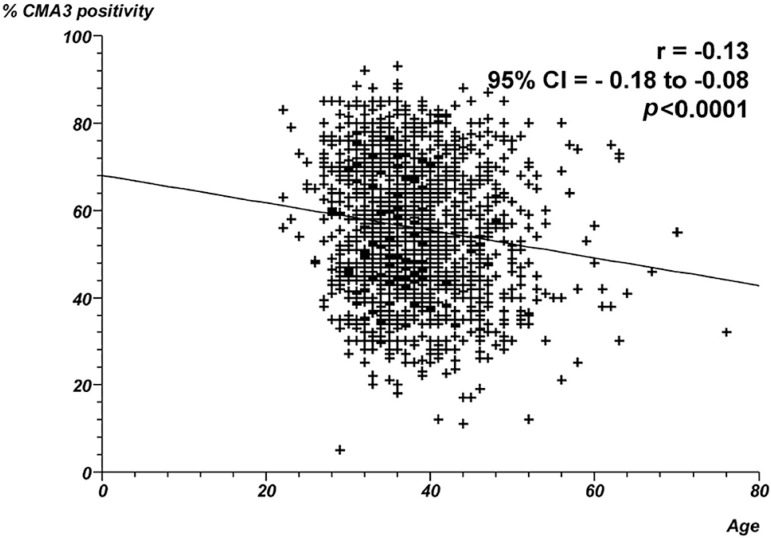
Correlation between male age and proportion of CMA positivity.
Individual data points and the regression line are shown. Spearman's
rank correlation coefficient =-0.13;
p<0.0001.